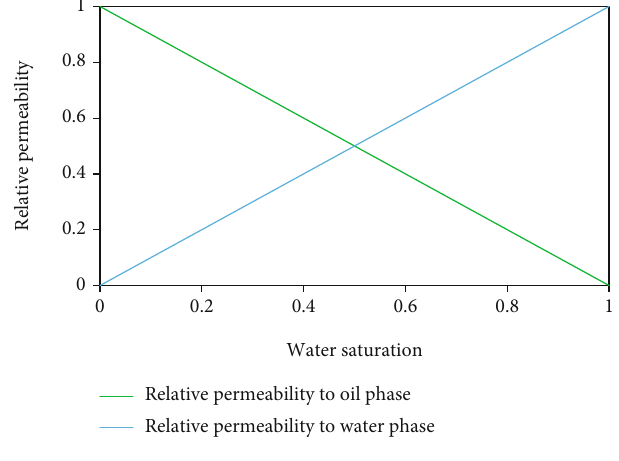
Figure 5: Oil-water relative permeability of the hydraulic fracture system.